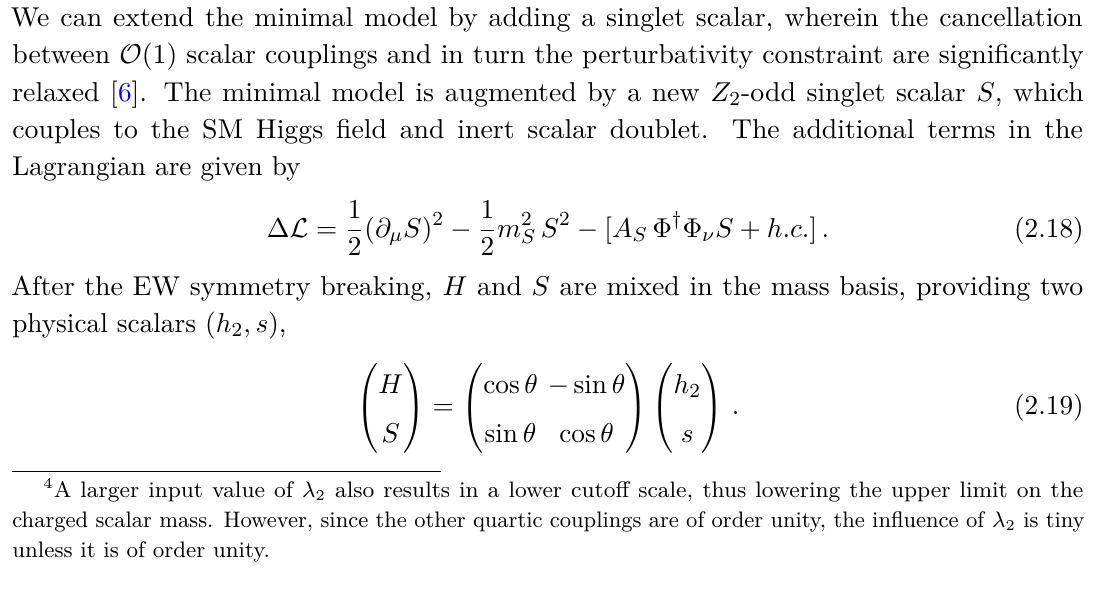
Figure 1 . Cutoff scale of the model at which the triviality or perturbative unitarity conditions break down. We impose the boundary condition eq. (2.16) as well as y τ (cyan) at µ = m . See the text for further in H ±